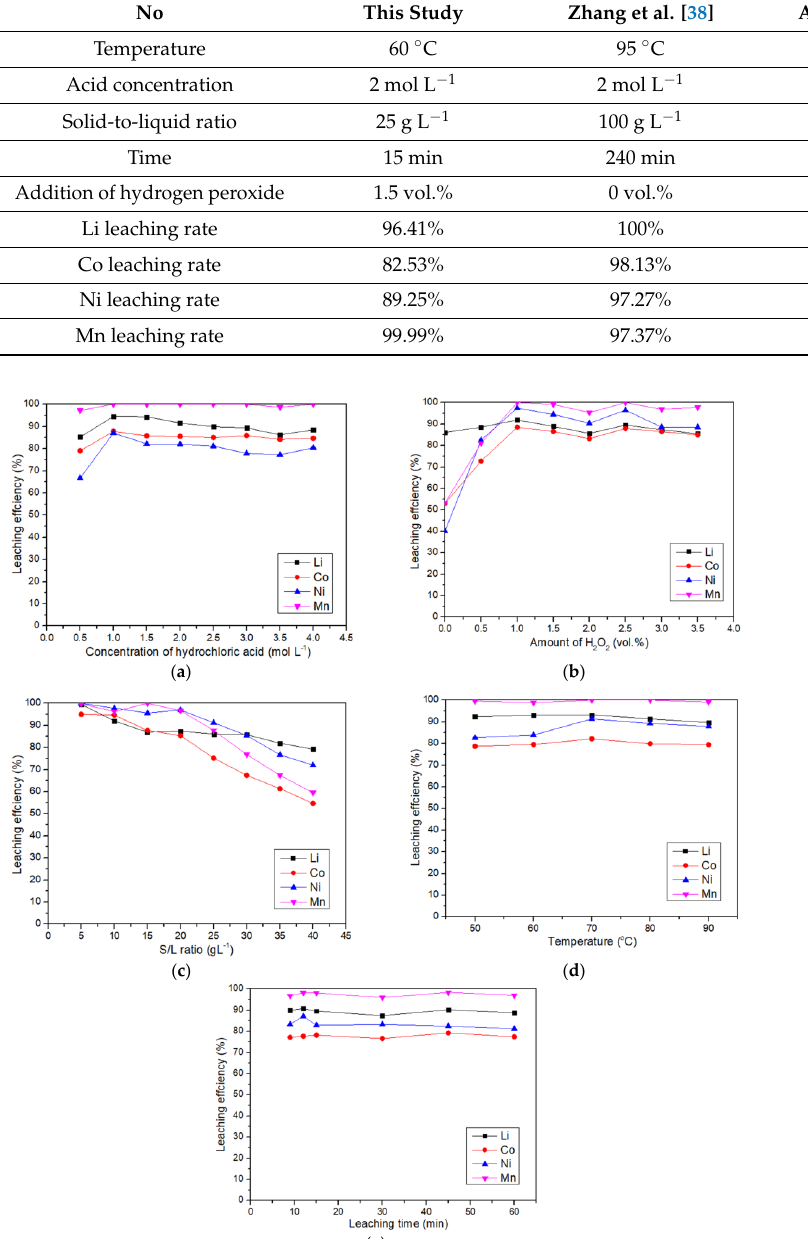
Figure 3. Effect of ( a ) acid concentration, ( b ) amount of H 2 O 2 added, ( c ) S/L ratio, ( d ) temperature, and ( e ) time on leaching efficiency of hydrochloric acid.